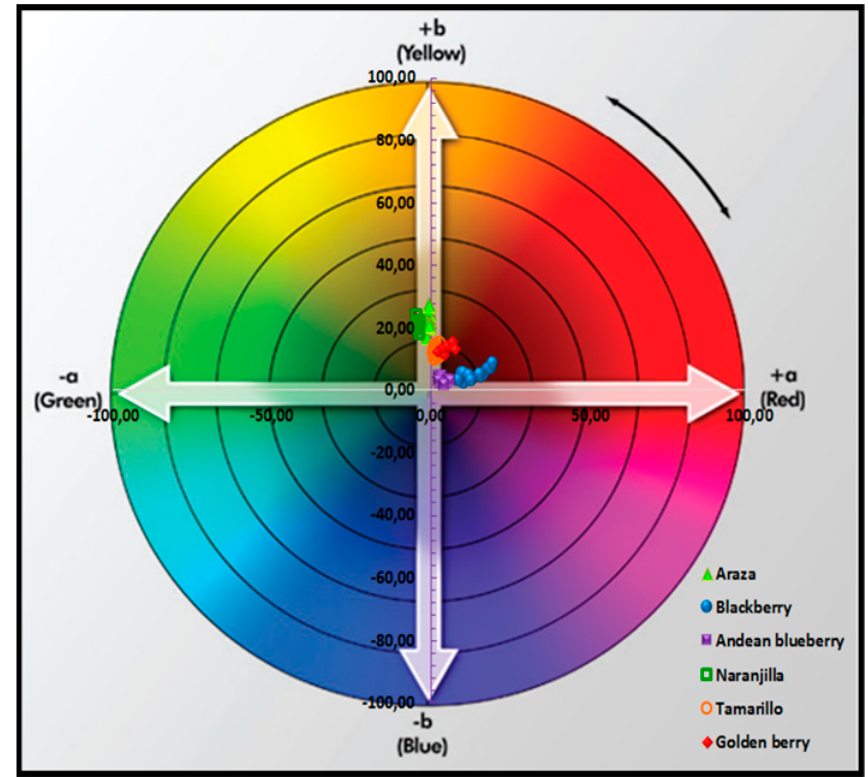
Figure 1. Chromatic representation of the CIE L*a*b* color coordinates of the tropical and Andean fruits.